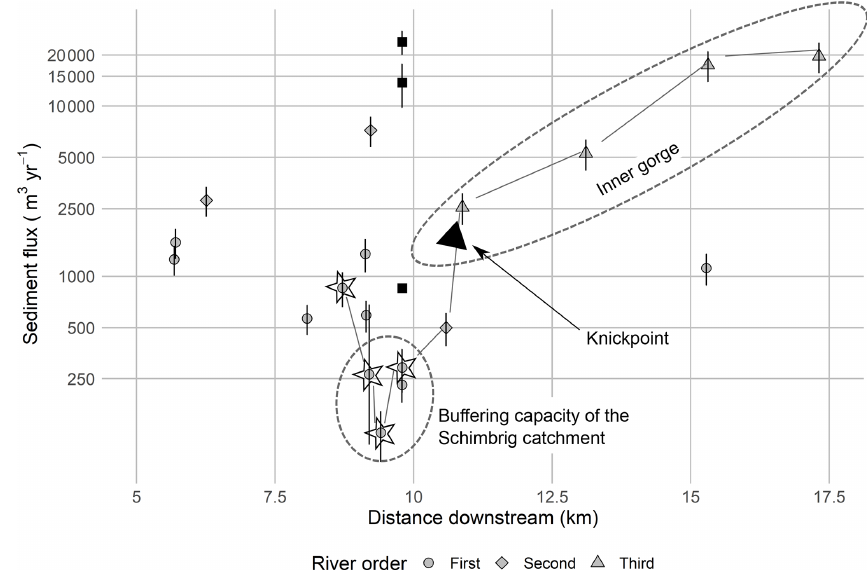
Figure 7. CRN-derived sediment fluxes (m 3 yr − 1 ) along the river network of the Entle catchment. Downstream distance is computed from the river source to the outlet of the Entle catchment. Samples from the earthflow-affected Schimbrig catchment are marked with a star. Black square markers represent the sediment flux computed by Schwab et al. (2008) for the period 1962–1998. Grey lines present the downstream sequence of denudation rates along the Schimbrig, Rossloch, Kleine Entle, and Grosse Entle rivers. Sediment flux values on the y axis are shown on a logarithmic